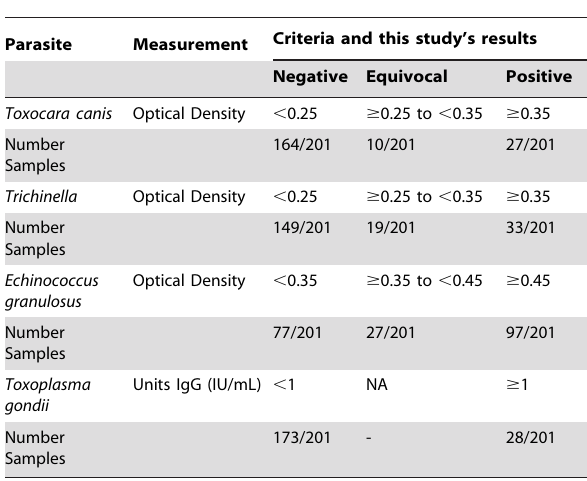
Table 1. Results of serological analyses and criteria for sero- status in